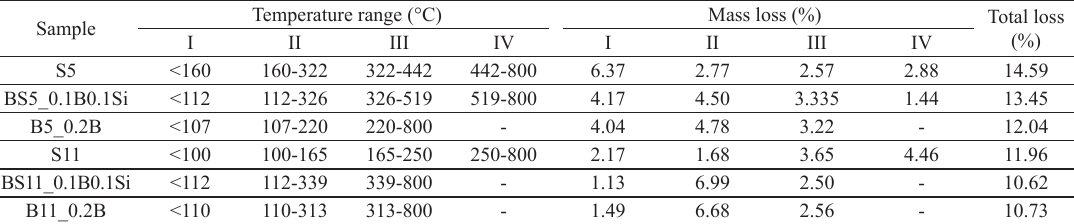
Table 4. Temperature range, partial and total mass loss of AFI/AEL samples. Sample